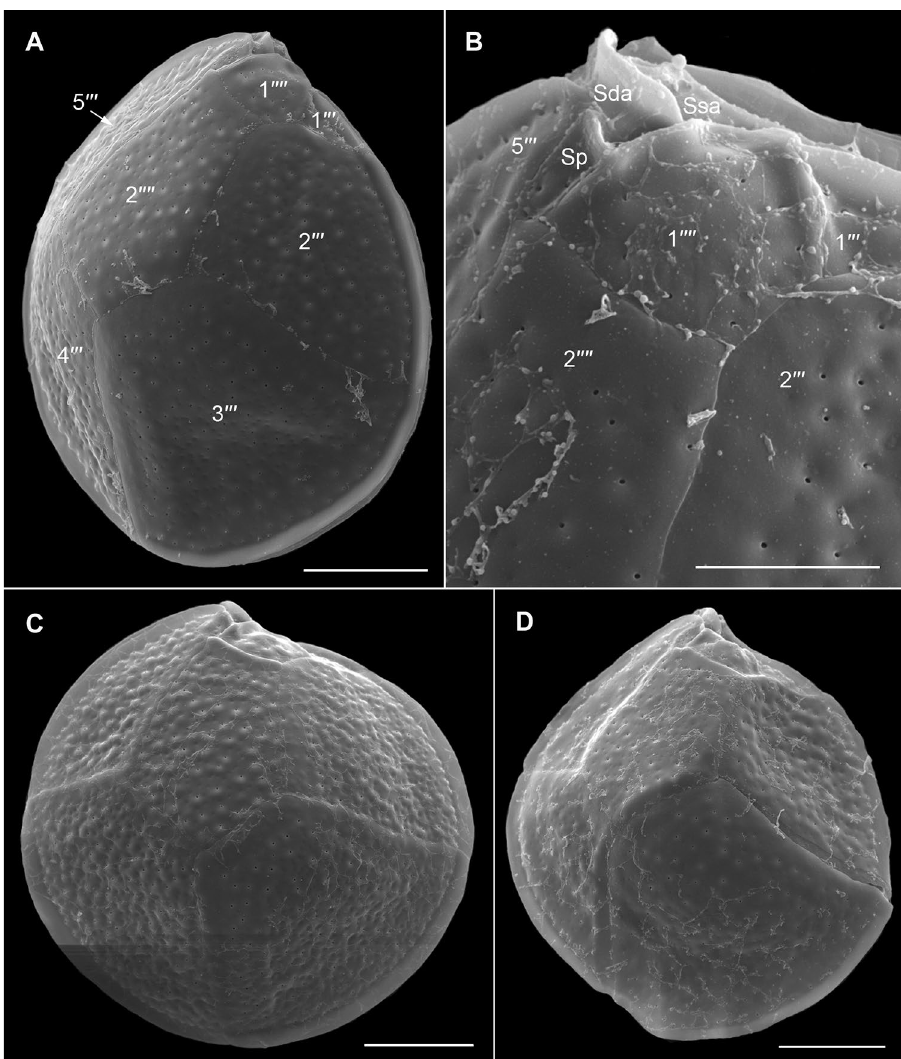
Figure 7. Scanning electron micrographs of Ostreopsis lenticularis cells from field samples showing the hypothecal tabulation. ( A ) Left lateral to antapical view. ( B ) Detail of the ventral area showing three sulcal plates, the posterior (Sp), the anterior right (Sda) and the anterior left (Ssa) sulcal plate. ( C,D ) Antapical view, note the different cell shapes. Scale bars = 20 µm, except B: 10